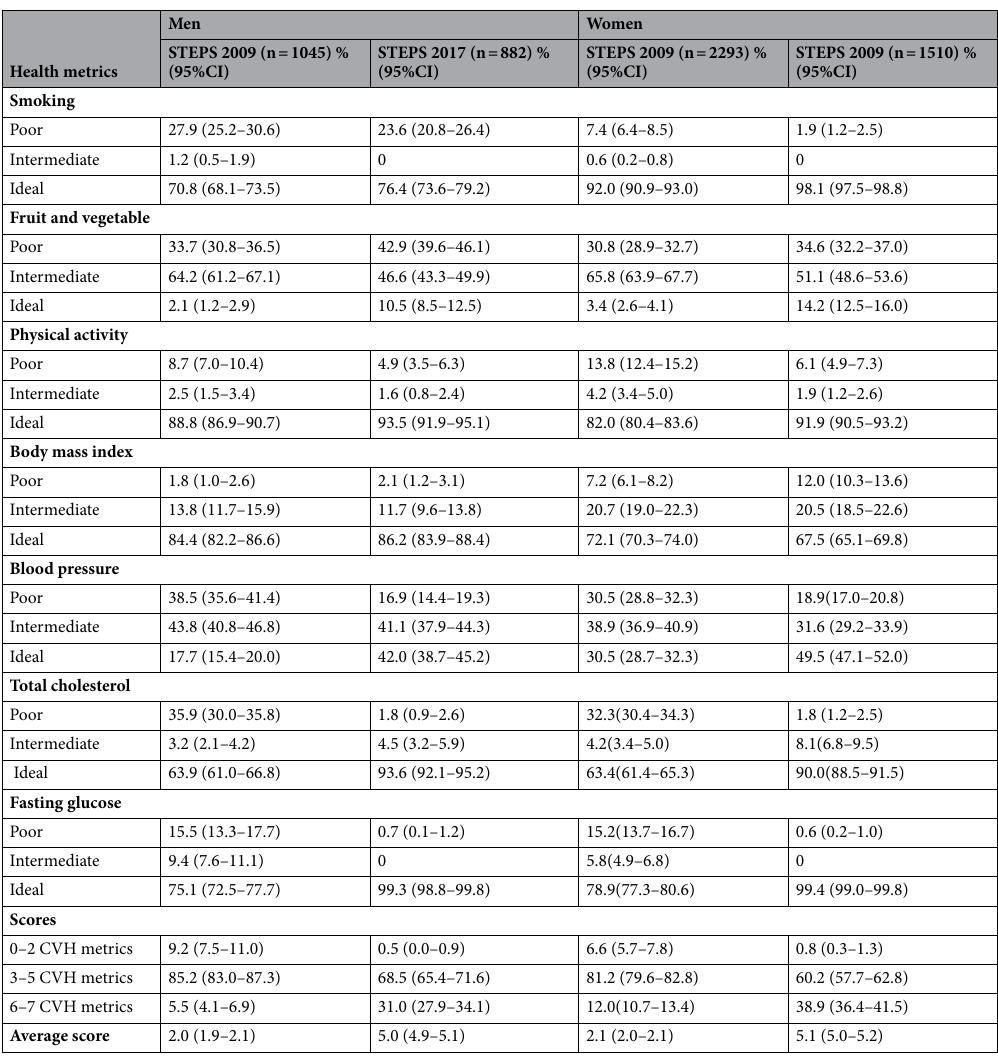
Table 4. Age-standardized prevalence of CVH metrics among males and females in Malawi